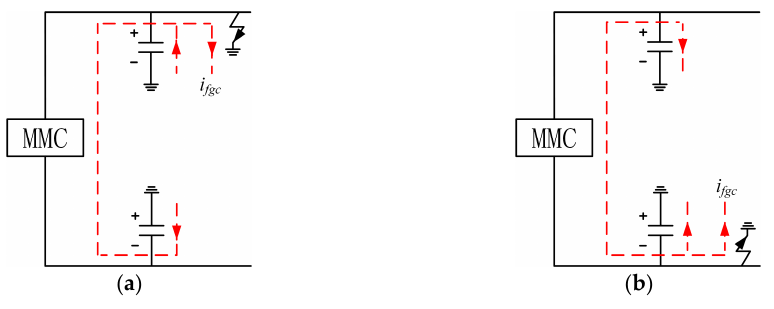
Figure 6. Fault current circuit of i fgc . ( a ) Positive pole-to-ground fault; ( b ) Negative pole-to-ground fault.